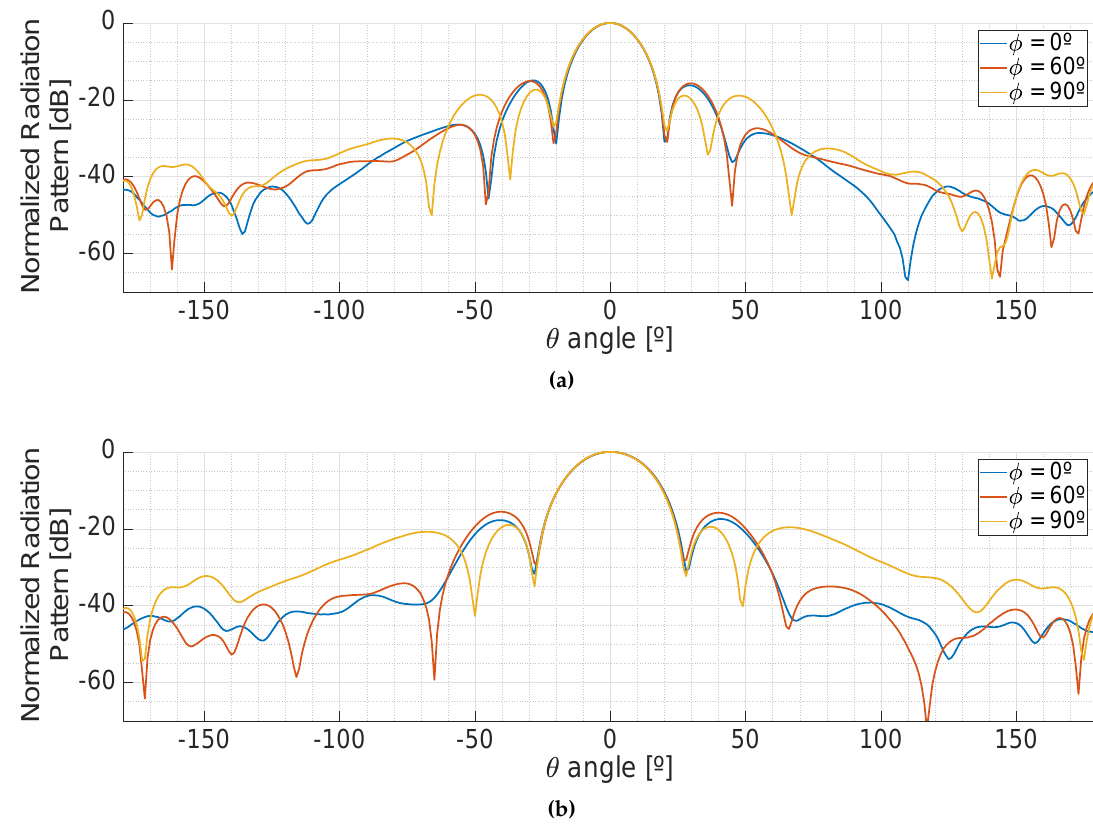
Figure 23. Azimuthal cuts of the full radiation pattern pointing to the boresight of the antenna, at the L1/E1 ( a ) and L5/E5 ( b ) frequency bands.